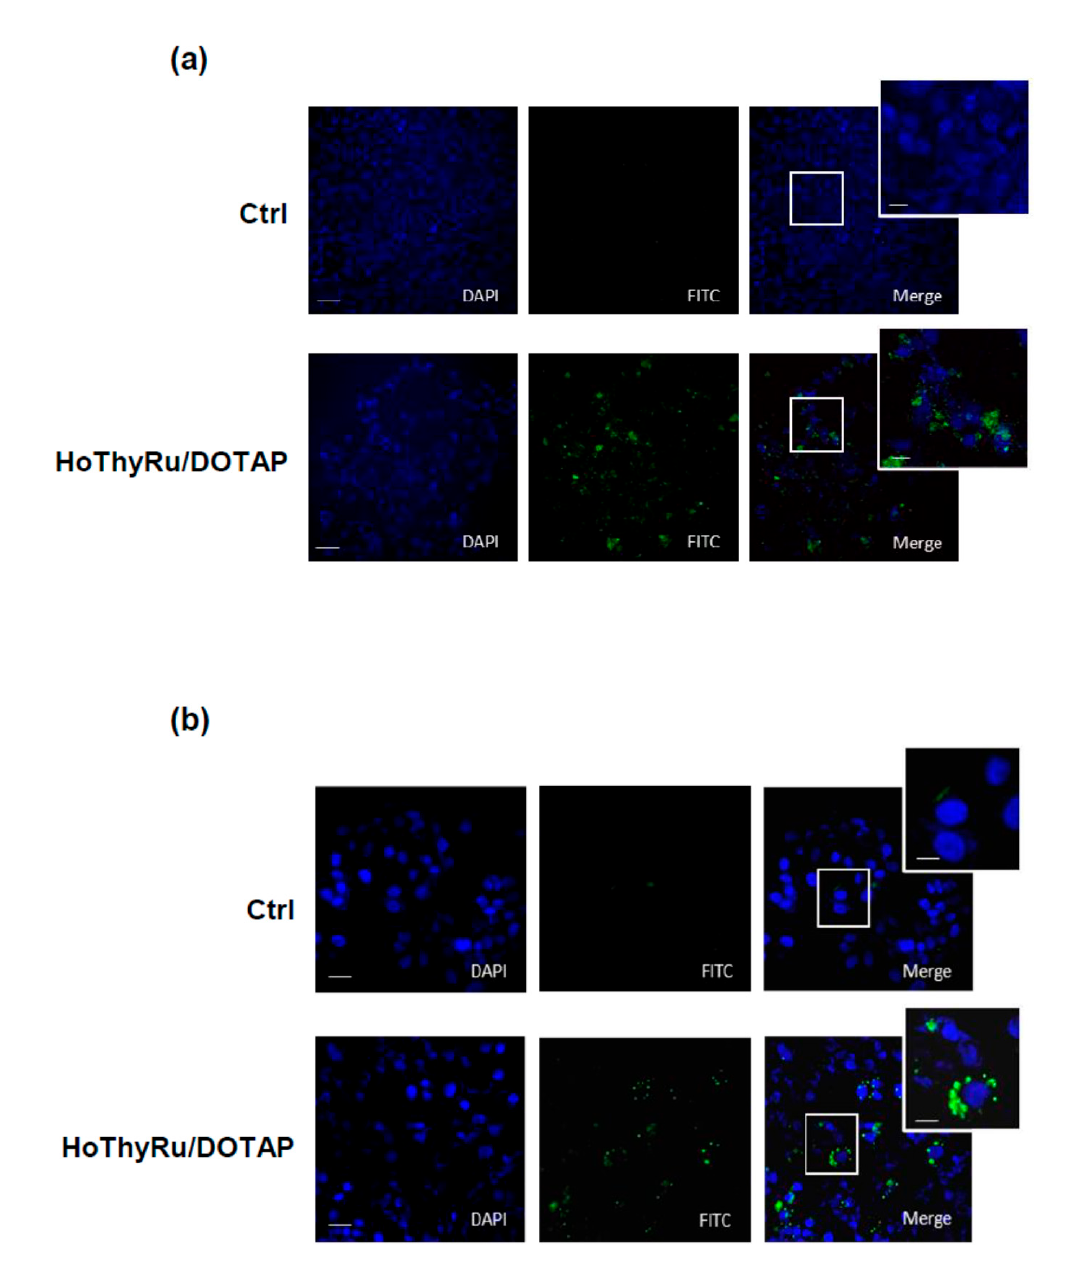
HoThyRu/DOTAP. A fluorescent “Apoptosis Detection kit” (Abcam, ab176749), designed to